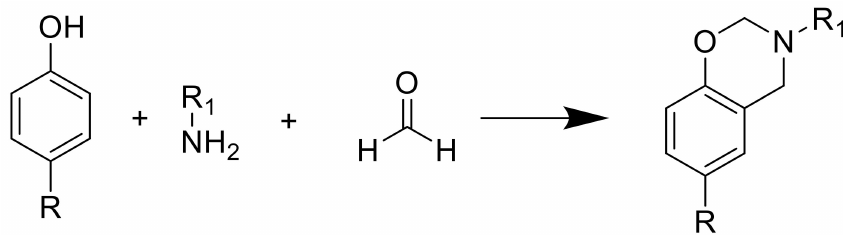
Figure 17. Synthesis of